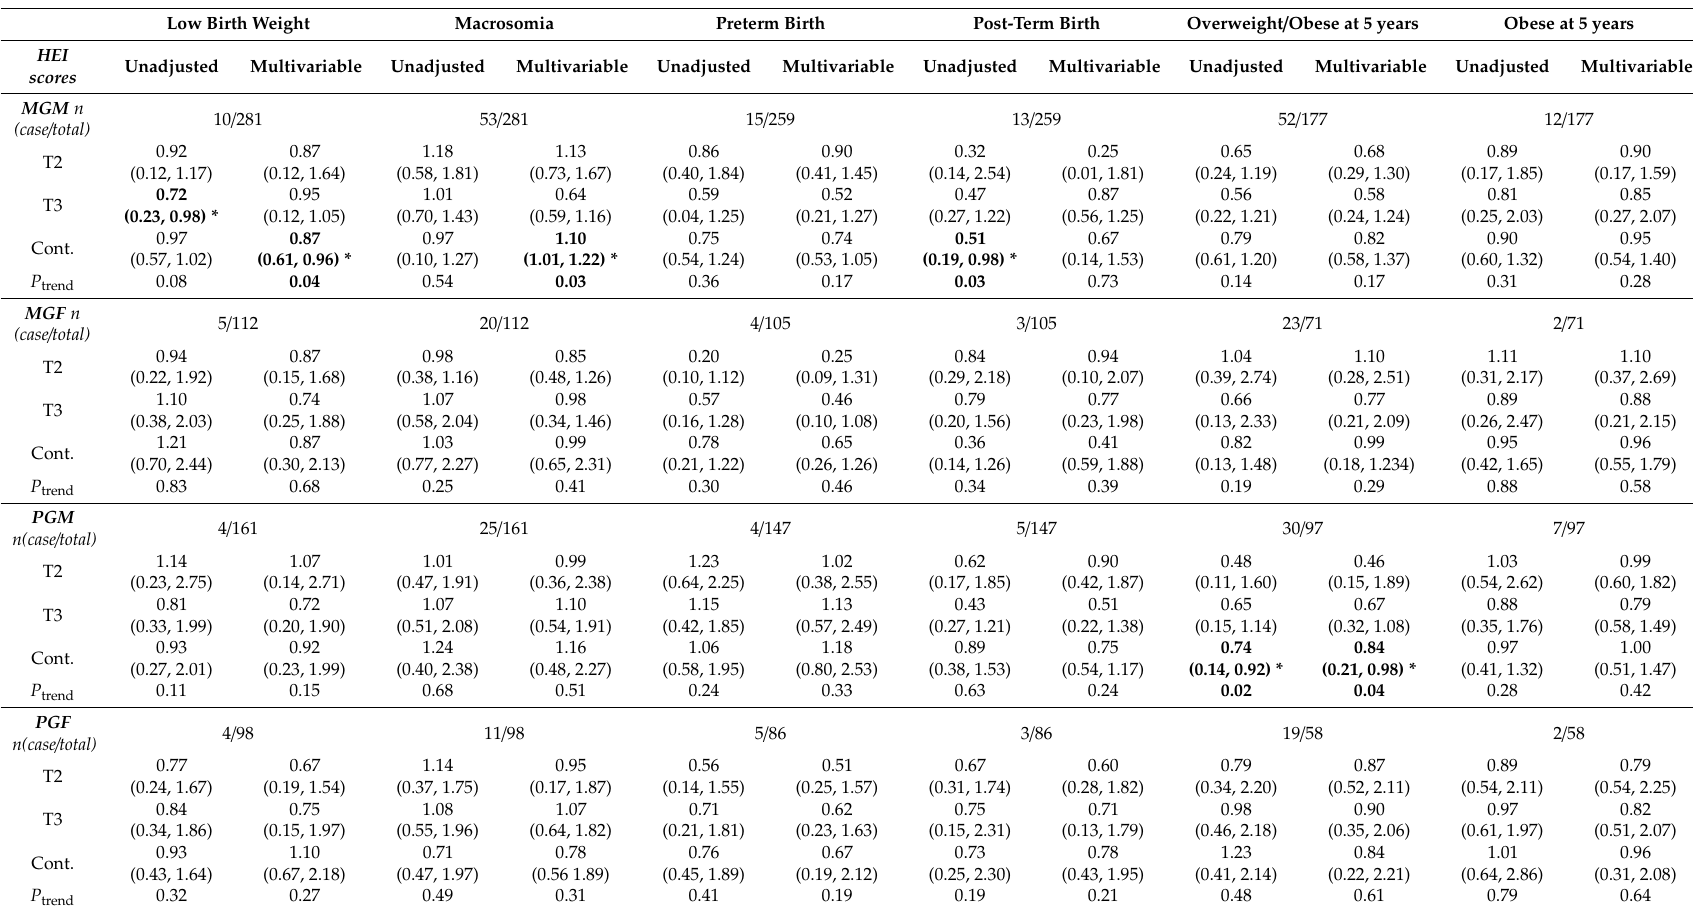
Table 4. Associations between grandparental HEI scores and binary o ff spring outcomes at birth and at five years 1 . Low Birth Weight Macrosomia Preterm Birth Post-Term Birth Overweight / Obese at 5 years Obese at 5 years Multivariable Unadjusted Multivariable Unadjusted Multivariable Unadjusted Multivariable Unadjusted Multivariable Unadjusted